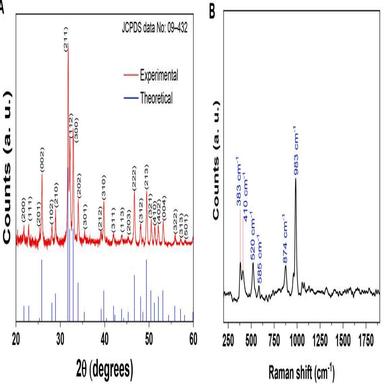
(A) XRD pattern of nanoporous HA. (B) Raman spectrum of nanoporous HA.